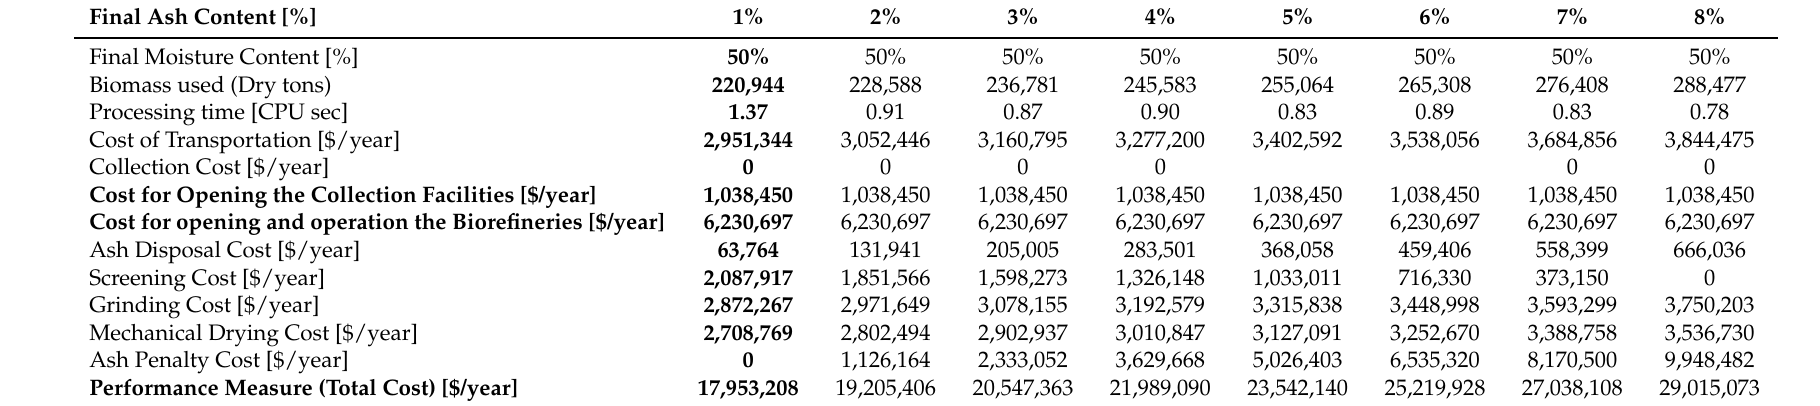
Table 2. Summary of the computational results (the annual costs are in USD). Optimal solution is in bold